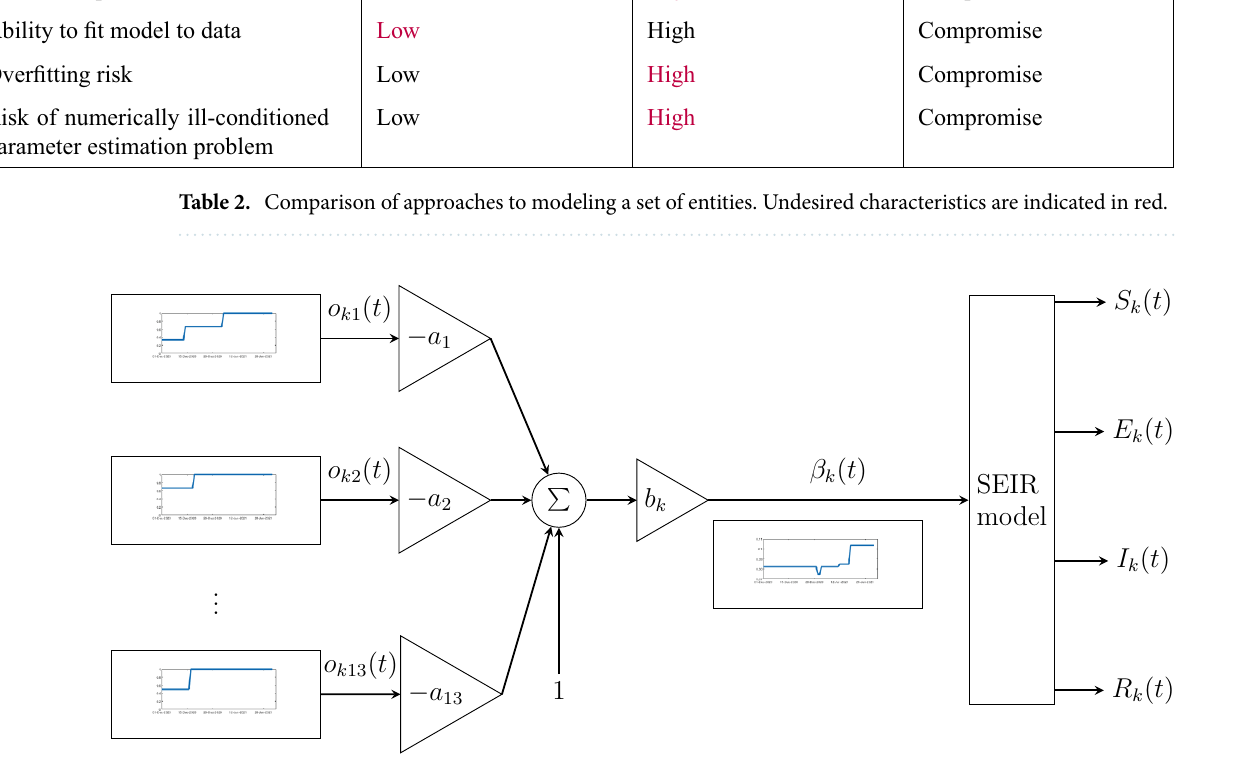
Figure 3. Block diagram of the entire COVID-19 mathematical model for the k th country. The non-stationary parameter β k ( t ) is calculated as a function of government policies o ki ( t ) . The diagram presents individualized version of the model (7), where parameters a i are common for all countries and the parameter b k is an individual parameter for the k th country. The structure of the common and the independent models are the same—the only difference is related to parameters of the function calculating β k ( t )